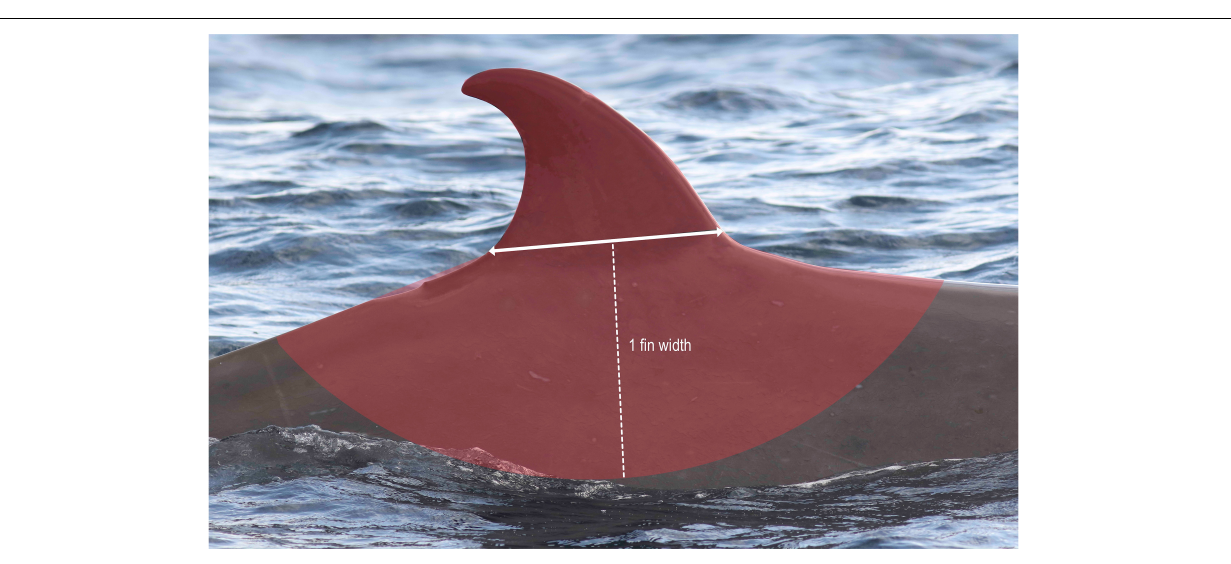
FIGURE 4 | The dorsal skirt area where markings and scars were evaluated for reliability are indicated in red